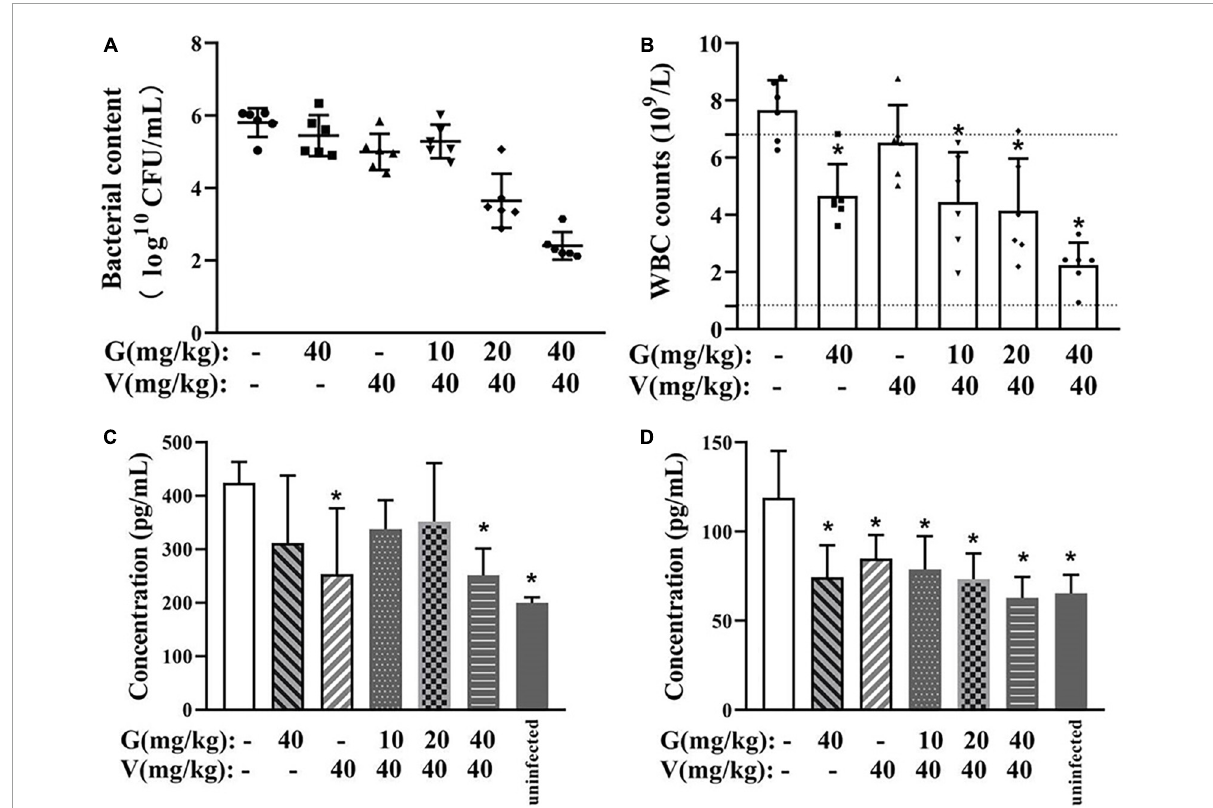
FIGURE8 Therapeutic effect of combinations of vancomycin and/or geraniol on the mice infection model. (A) Bacterial count in implants, (B) white blood cell counts in mice, serum (C) TNF- α and (D) IL-6 levels in model mice after treatment. ∗ p < 0.05 compared with the 0 µ g/mL